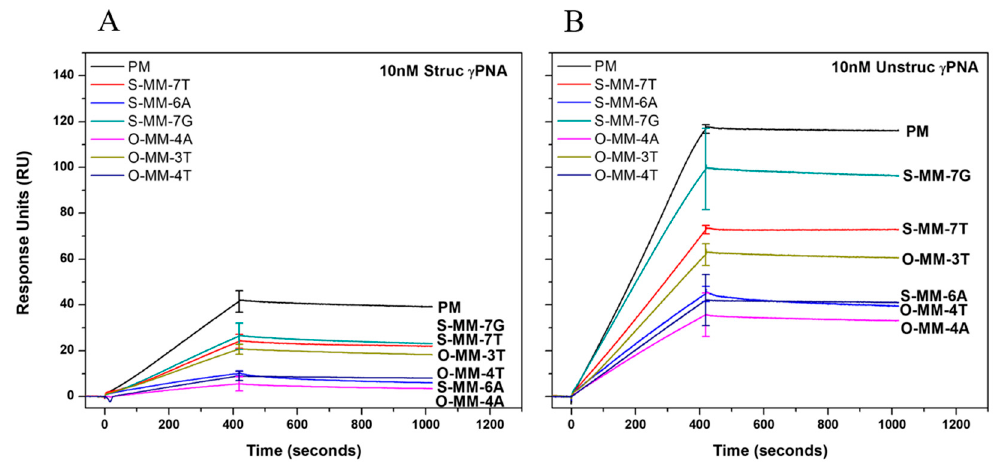
Figure 2. Surface plasmon resonance (SPR) sensorgrams for 10 nM struc_ γ PNA ( A ) and unstruc_ γ PNA ( B ). DNA target sequences are given in Table 1. All data are plotted as n = 3 average ± SD.